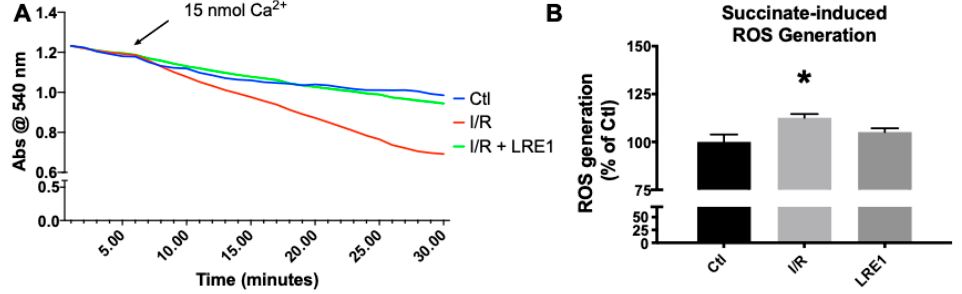
Figure 3. Mitochondrial swelling recording ( A ) and reactive oxygen species (ROS) generation ( B ). Swelling was recorded by following absorbance of light at 540 nm after a Ca 2+ challenge, while ROS was evaluated by following 2 ′ ,7 ′ -dichlorodihydrofluorescein diacetate (H2DCFDA) fluorescence for 10 min. For panel A, lines indicate a representative recording of all of the assays, while panel B represents means ± SEM of 4 independent experiments. * indicates a statistically significant difference vs. Ctl.